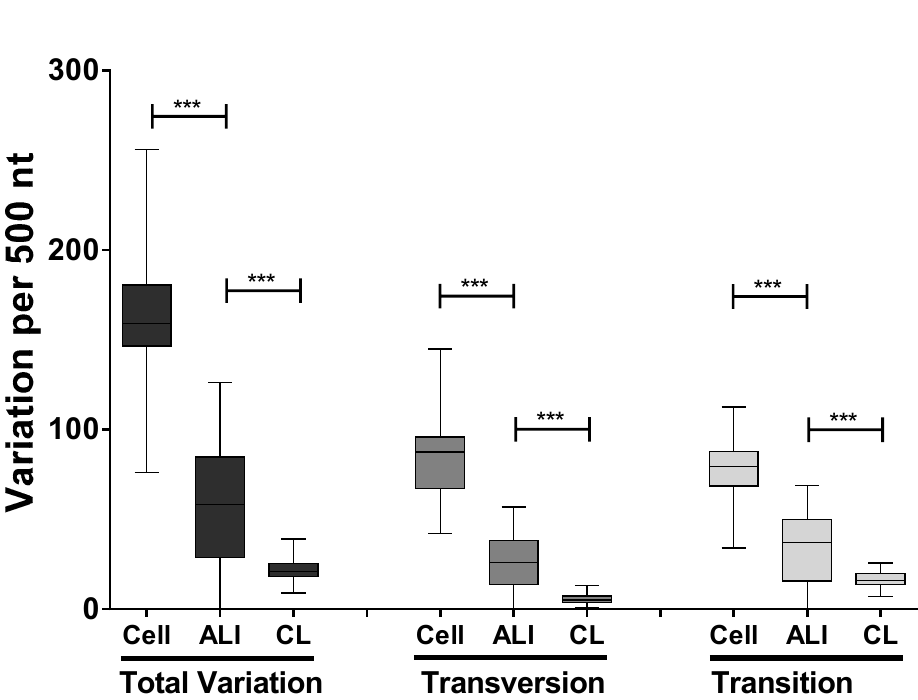
Figure 4. Transition and transversion analyses of each condition. The analysis was implemented using a 500-nucleotide sliding window across the HRSV genome. Each box plot indicates the mean value, the 25th and 75th percentiles, and the 95% confidence interval (CI) of the mean. The analysis was also performed using a 100-nucleotide sliding window and the results were similar. Cell, the air liquid interface (ALI) and clinical samples CL refers to viral RNA sequenced from cell culture, air liquid interface samples and clinical samples. Statistical significance was estimated using Kruskal-Wallis with the significance threshold p < 0.05. Viruses 2019 , 11 , x FOR PEER REVIEW